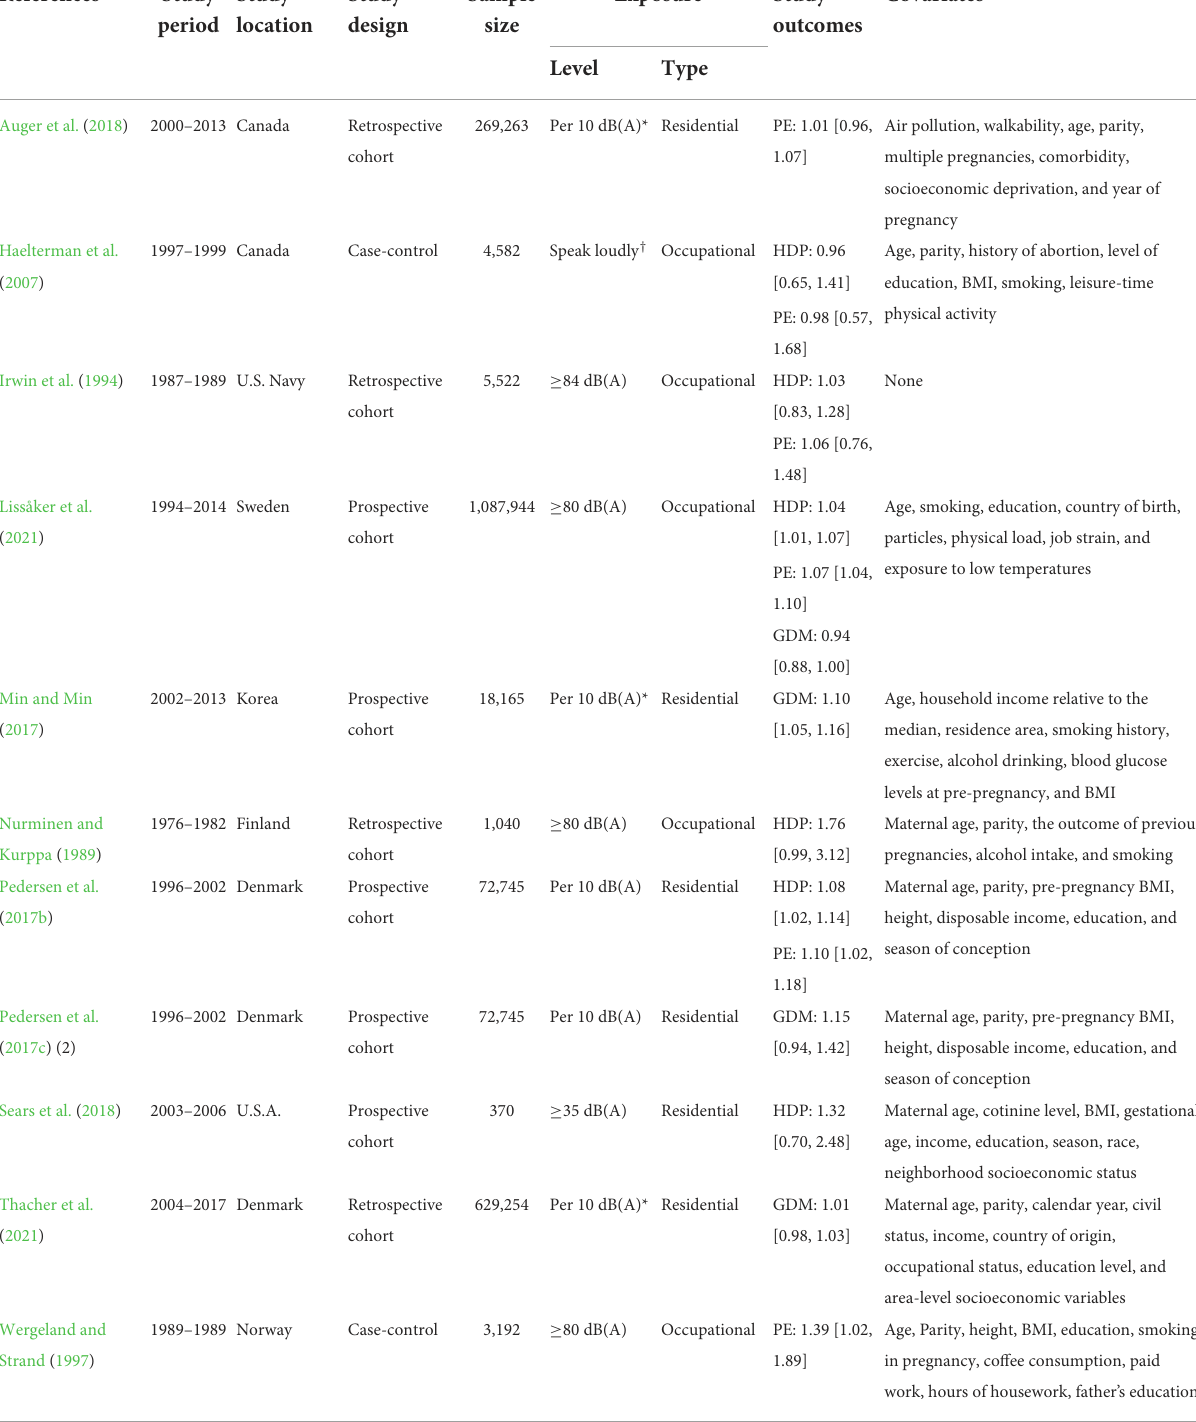
TABLE 1 Characteristics of studies on the relationship between noise exposure during pregnancy and pregnancy